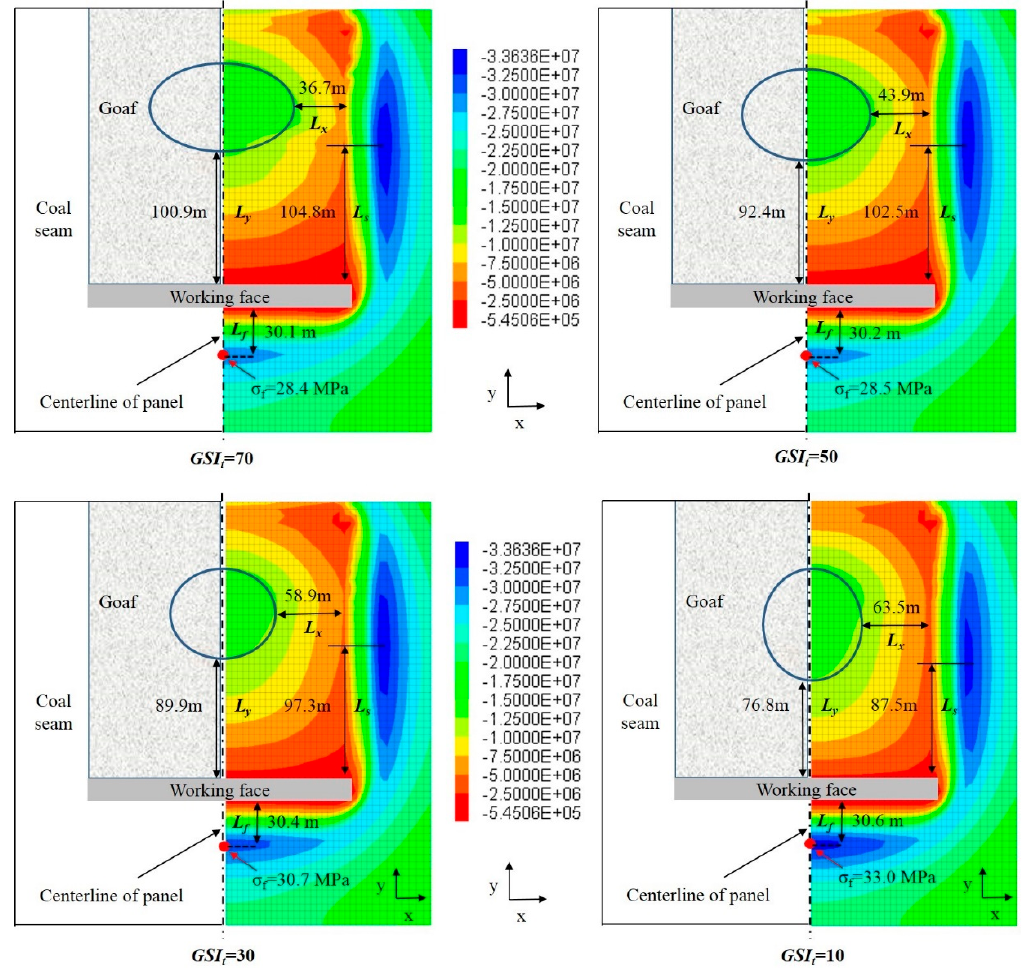
Figure 7. Distribution of the mining-induced vertical concentrated stress with respect to different GSI t values.